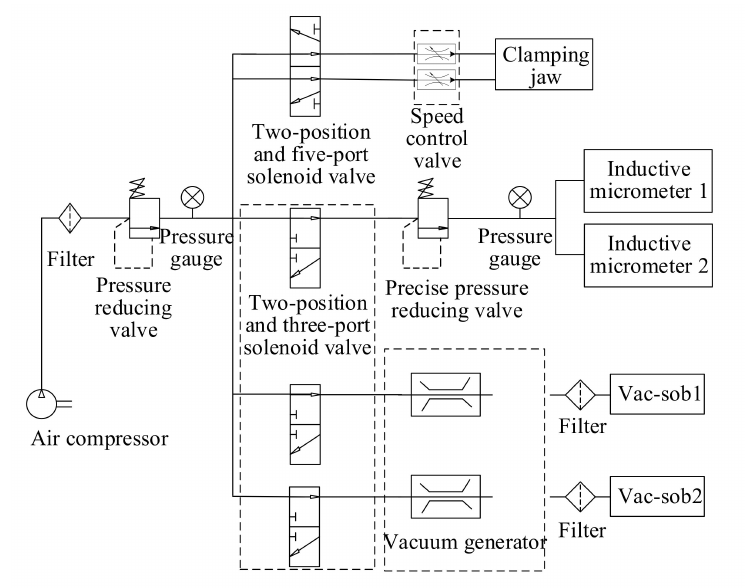
Figure 9. Schematic diagram of the pneumatic control system.